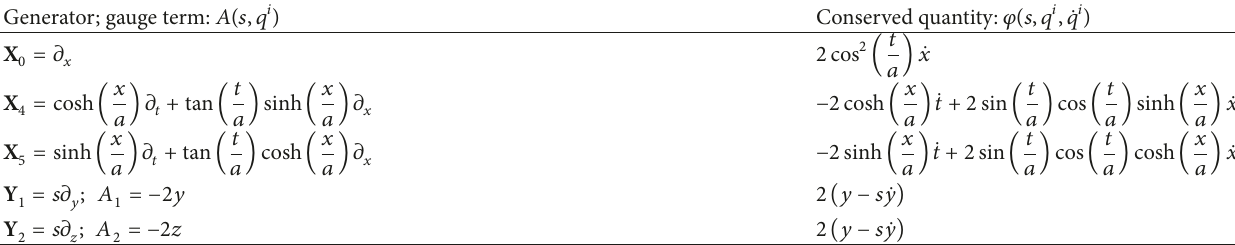
Table 9: Conserved quantities corresponding to each Noether symmetry.